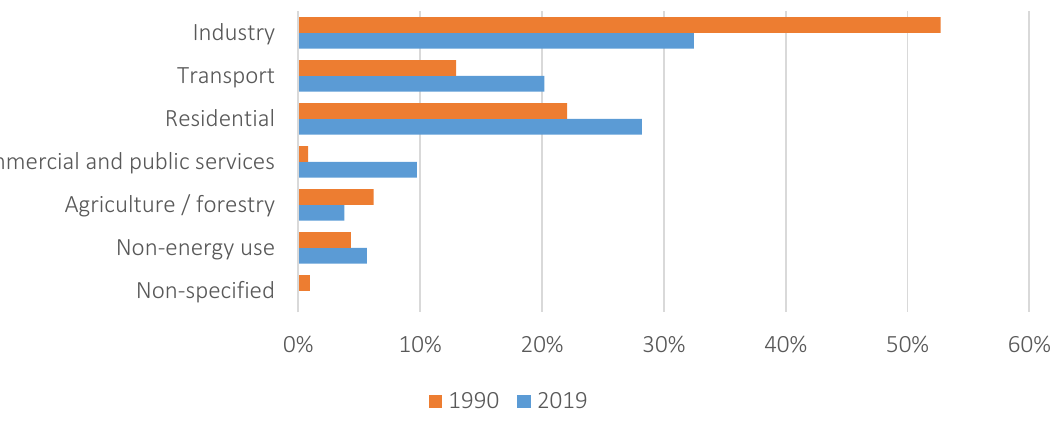
Figure 5. Share of total final energy consumption by sector in Ukraine in 1990–2019, %